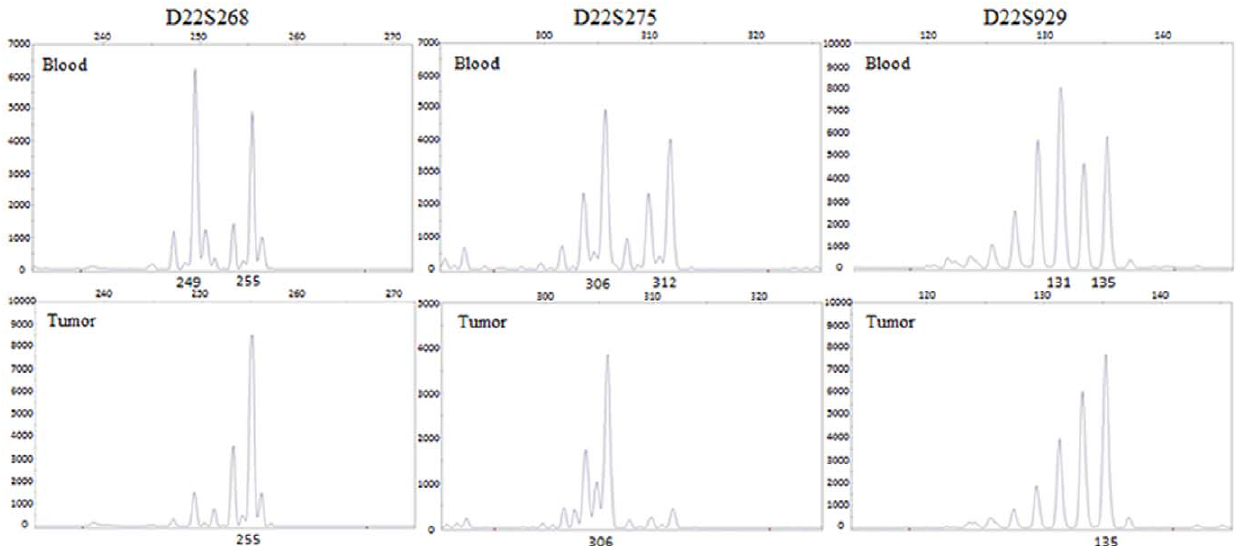
Figure 1. Loss of heterozygosity analysis of case No.1. A comparison of lymphocyte DNA and tumor DNA using the flanking, D22S268 and D22S275, and intragenic, D22S929, microsatellite markers in the NF2 gene region. In case, three markers showed loss of heterozygosity by allele loss in the tumor DNA.